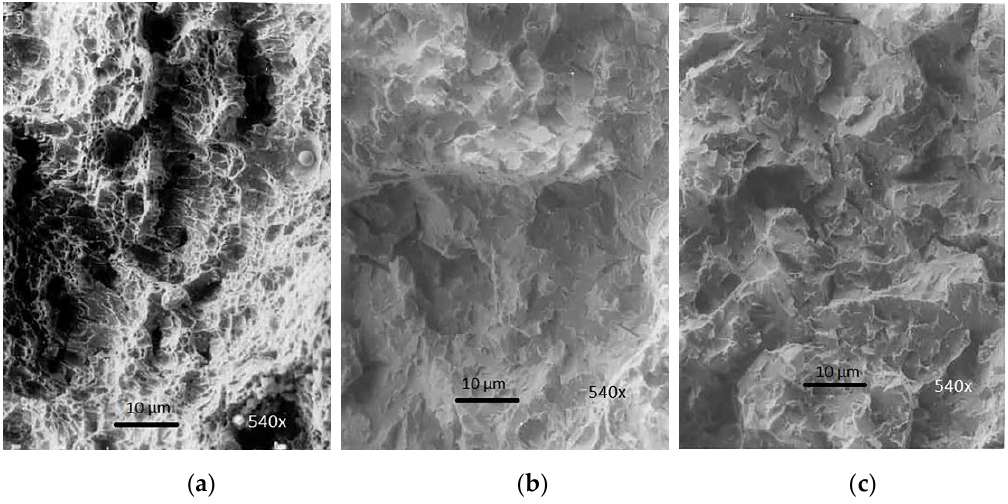
Figure 7. SEM fracture surface view of testing of toughness of WM formed by using electrode No.1.1: ( a ) ( t = +20 °C), ductile fracture; ( b ) ( t = −40 °C), brittle fracture of transcrystalline and intercrystalline character in the middle of WM; ( c ) ( t = −60 °C), brittle fracture of transcrystalline and intercrystalline character in the middle of WM.